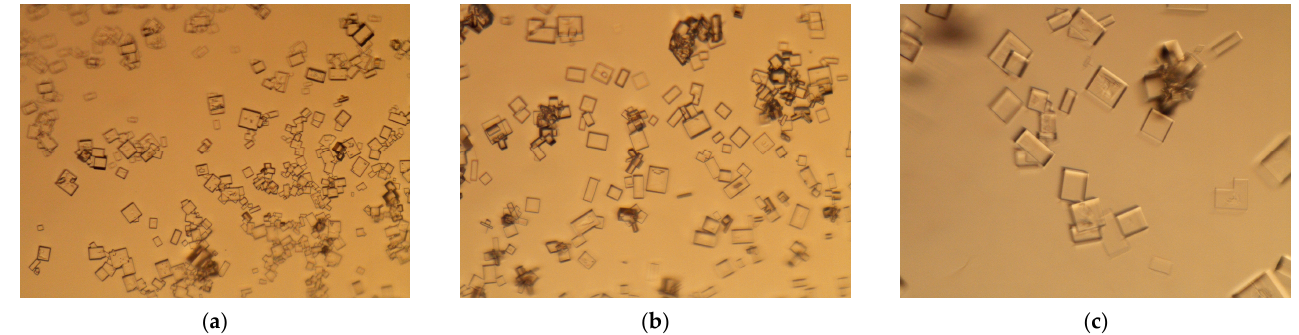
Figure 8. Pictures collected on different samples of NaCl crystals obtained with PVDF/BT (0.5%) membrane (magnification 20×): after ( a ) 140, ( b ) 170 and ( c ) 200 min.